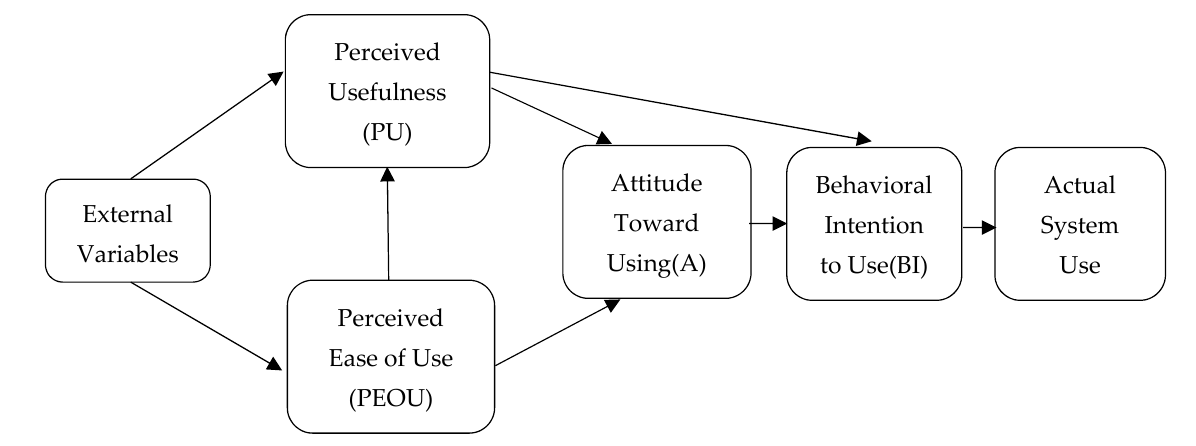
Figure 1. Technology acceptance model.